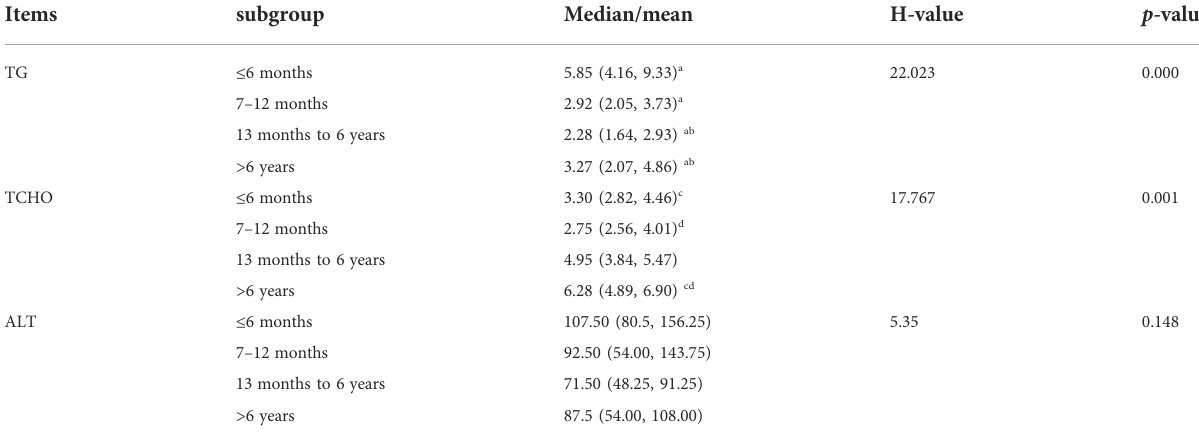
TABLE2DifferentialanalysisofTC,TCHO,andALTindifferentagegroups.Signi fi cantdifferencesexistedinTGandTCHOindifferentagegroups( P < 0.05), but there were no statistical differences in ALT between four groups ( P > 0.05) (a, b, c, and d are used to represent the statistical difference between groups with the same superscript